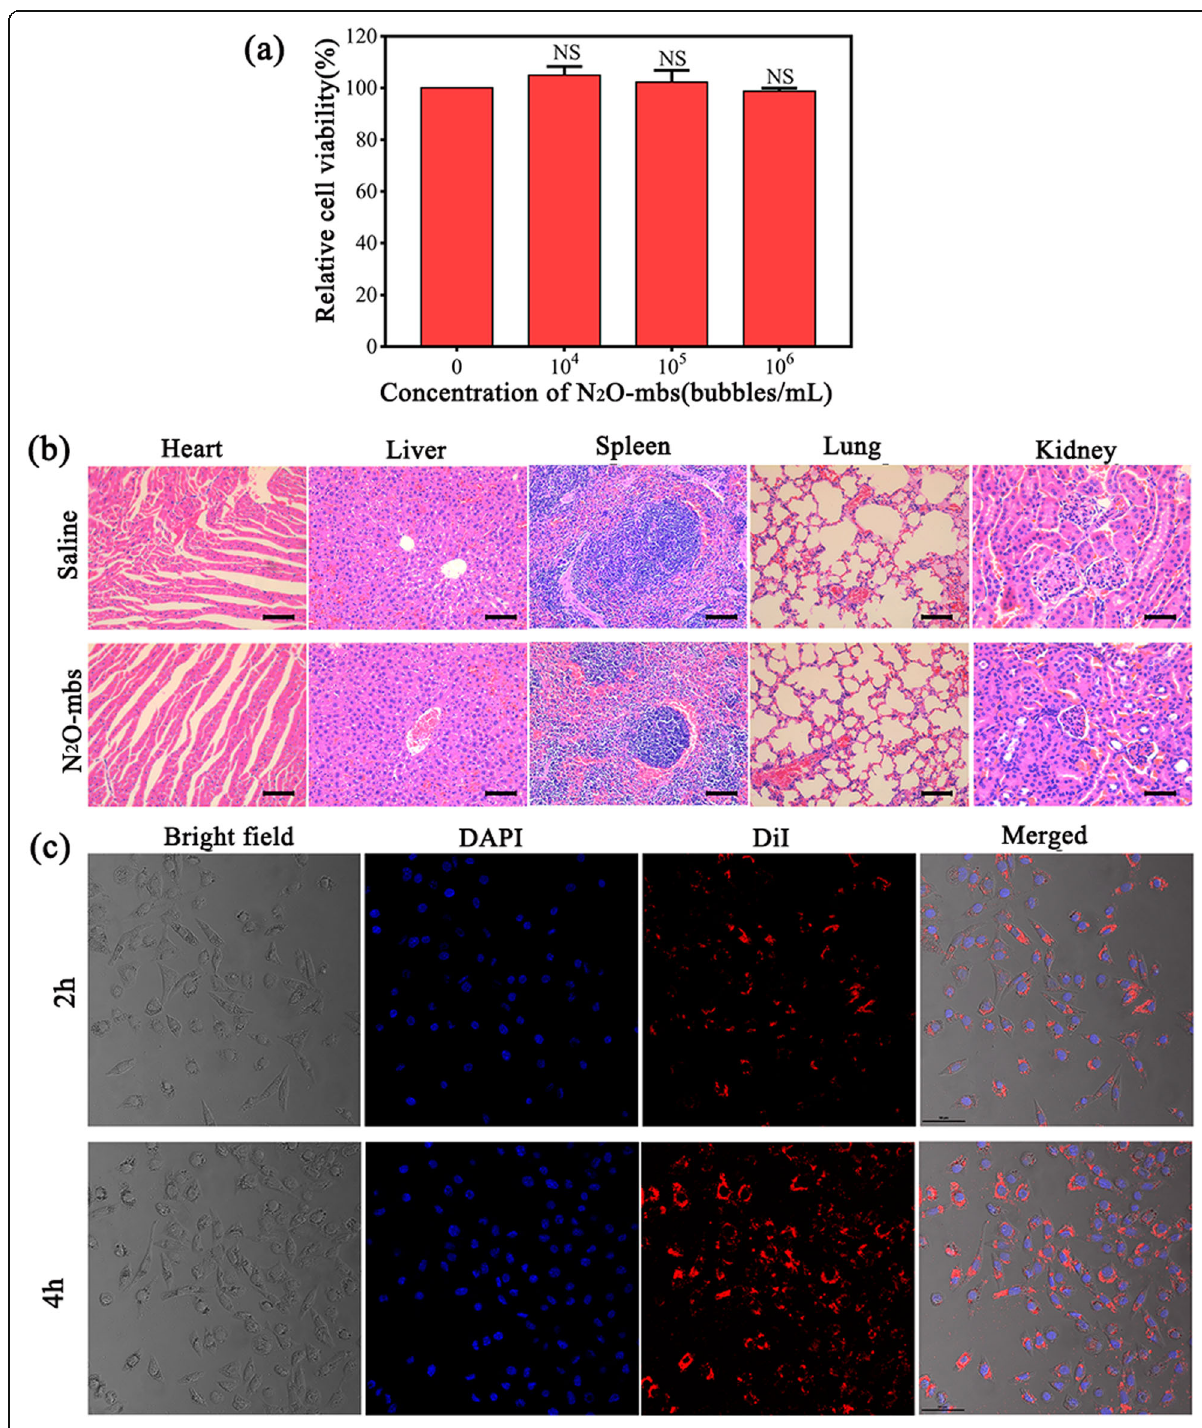
Fig. 2 a Cell viability was determined by CCK-8 assay; b H&E staining of the major organs (heart, liver, spleen, lung and kidney) in healthy female nude mice with or without receiving the N 2 O-mbs; c the images from a to d show cell in bright field, cell nuclei stained by DAPI, N 2 O-mbs stained by DiI, and the merged results of the three fluorescence images; scale bar = 50 μ m [ NS no significance, compared with control group (0